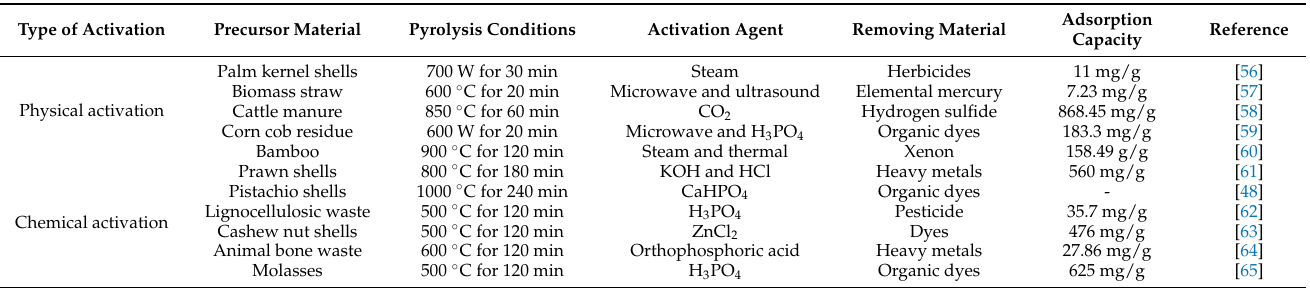
Table 1. Comparison of the functional properties of using different activation approaches for activated carbon